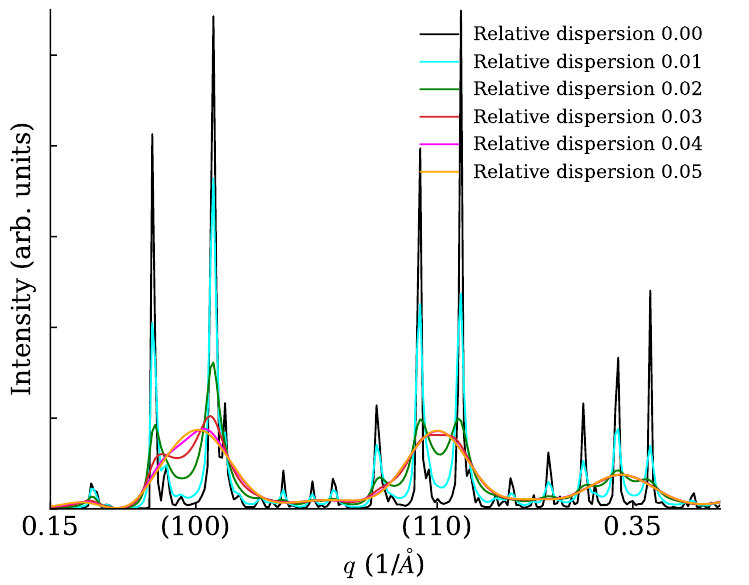
Figure 7. XRPD scattering from a cube (3D SC) with various levels of relative SL spacing dispersion.